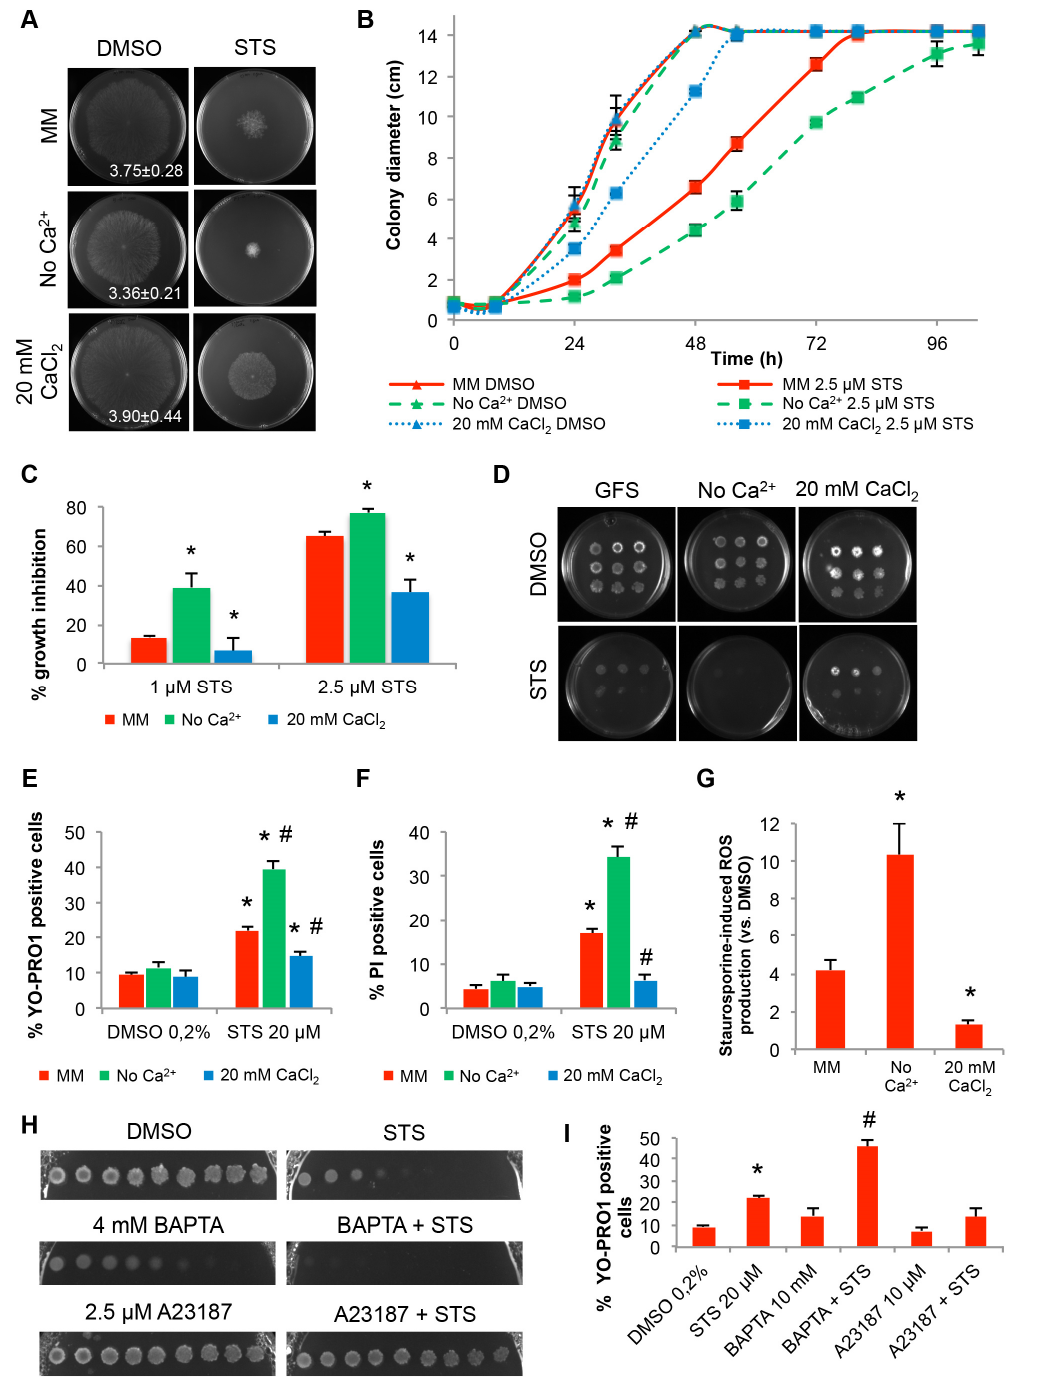
FIGURE 1: Extracellular Ca 2+ modulates the N. crassa sensitivity to staurosporine. (A-C) Conidia were inoculated on the centre of a Petri dish containing Vogel’s MM with 2.5 μM staurosporine (STS) and different concentrations of Ca 2+ . Growth at 32h (A) , over time (B) and the percentage of growth in STS-treated cells versus control (C) are shown. Growth rates (mm/h) are indicated in the left panels in (A) . *, p- value ≤ 0.05. (D) Serial dilutions (from left to right) of conidia spotted in GFS agar medium supplemented with 5 μM STS and different con- centrations of Ca 2+ were incubated for 3 days. (E-F) Cell death following treatment of the cells with 20 μM staurosporine in the indicated liquid culture media was evaluated by flow cytometry quantification of positive cells for YOPRO-1 (E) or PI (F) . *, p-value ≤ 0.05 for the comparison STS versus DMSO in each media; #, p-value ≤ 0.05 for the comparison between media after the treatment with STS. (G) The fold increase in cellular ROS accumulation following treatment with 20 μM staurosporine in the indicated liquid culture media was evaluated by staining with DHR123. *, p-value ≤ 0.05. (H-I) Growth inhibition and cell death in 2.5 μM STS-treated cells in the presence of BAPTA or A23187 was assessed by spots in GFS medium (H) or cell growth in liquid medium followed by staining with YOPRO-1 (I) *, p-value ≤ 0.05 for the comparison STS versus DMSO; #, p-value ≤ 0.05 for the comparison between STS alone and